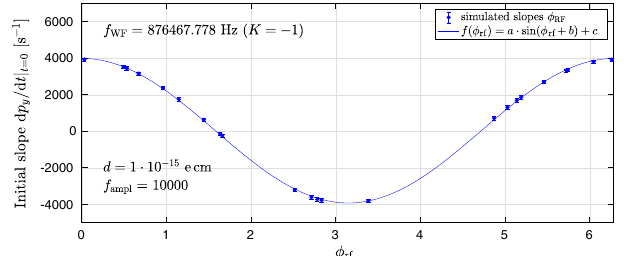
FIG. 13. Initial slope as a function of 24 random values ¼ 10 4 and of ϕ using a field amplification factor f rf ampl the indicated EDM. The simulated data are fitted using the function indicated in the inset. The resulting parameters are a ¼ ð 3959 . 122 (cid:4) 35 . 344 Þ , b ¼ ð 4135 . 901 (cid:4) 0 . 009 Þ , and c ¼ ð 39 . 861 (cid:4) 25 . 995 Þ . Each data point is obtained from a graph like the one shown in Fig. 9, but for ten turns and 1001 which agrees numerically well within errors with the value given in the last line of Eq. (79).